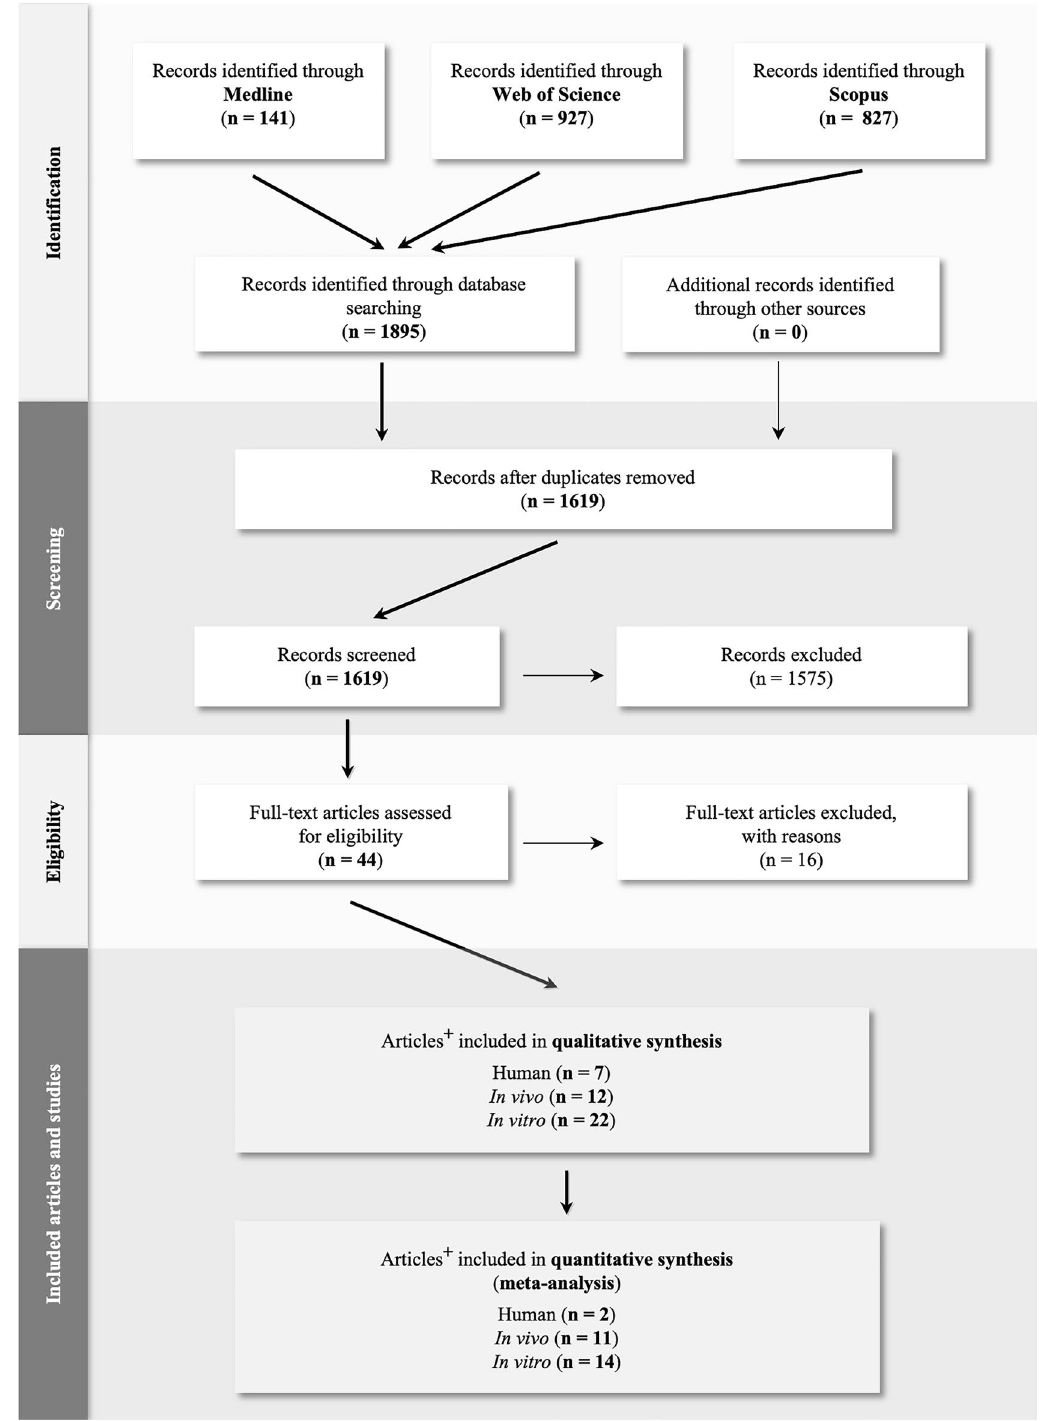
Figure 1. Systematic Reviews and Meta-analysis (PRISMA) flow diagram of evidence search and study selection process. + A number of included articles featured more than one study type (i.e. in vitro, in vivo and/or human studies). n denotes number of